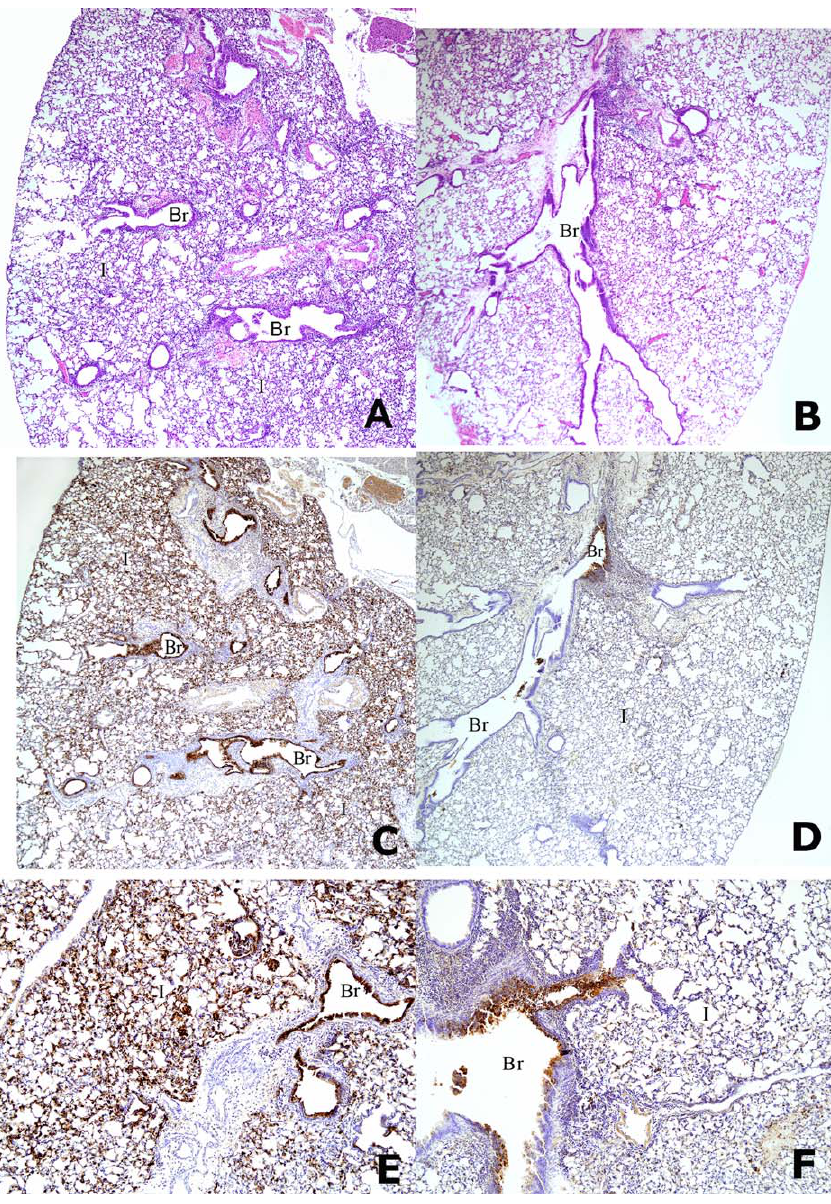
Figure 3. Histopathology in Pulmonary Tissue of Passively Immunized and Challenged Mice (A) Hematoxylin and eosin-stained lung sections (40 3 ) revealed diffuse interstitial pneumonia (I) and bronchial and bronchiolar (Br) involvement in a mouse infected with influenza A/VN/1203/04 (H5N1) after i.p. injection of the control mAb D2.2. (B) Mouse given mAb FLA5.10 prior to infection with influenza A/VN/1203/04 (H5N1), showing much less lung involvement than in (A). (C) Immunohistochemistry (40 3 ) revealed H5 antigen in bronchi, bronchioles (Br), and interstitial lesions (I) in a mouse given influenza A/VN/1203/04 (H5N1) following i.p. injection of the control mAb D2.2. (D) H5 antigen in bronchus (Br) and not in bronchioles or interstitial areas (I) in a mouse given mAb FLA5.10 prior to influenza challenge. (E) High magnification (100 3 ) of (C) showing abundant H5 antigen in interstitial alveolar lesions (I) and bronchiolar epithelium (Br). (F) High magnification of (D) (100 3 ) showing H5 antigen only focally in a bronchus (Br) and not in the interstitial alveolar areas